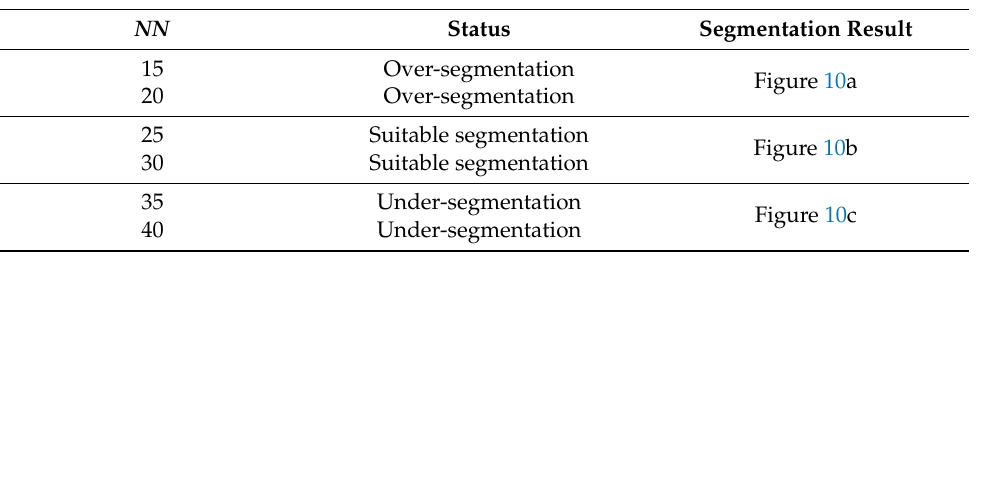
Table 6. Segmentation results of different NN values.